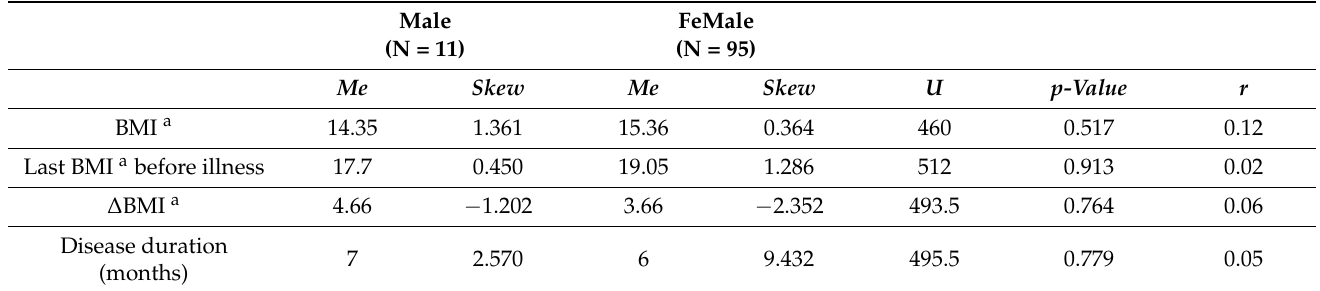
Table 2. Clinical features of Early adolescence Participants at admission.